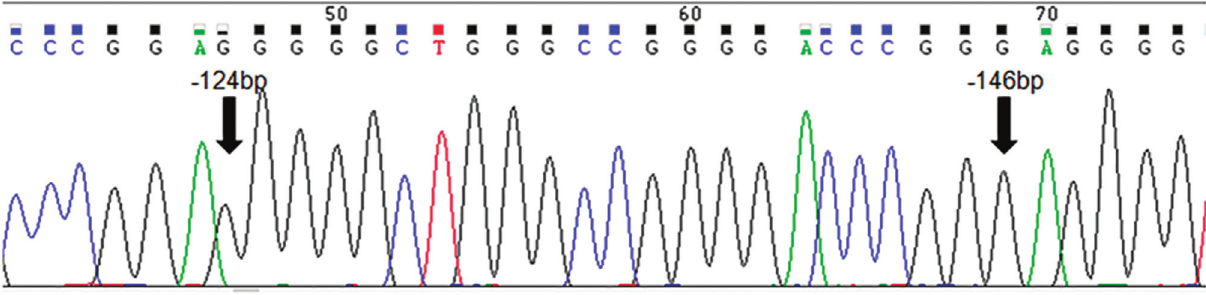
Figure 1 - Electropherogram of TERT showing the wild-type sequence for both hotspot mutation regions. The arrows indicate the hotspot mutation re- gions (-124bp and -146bp).